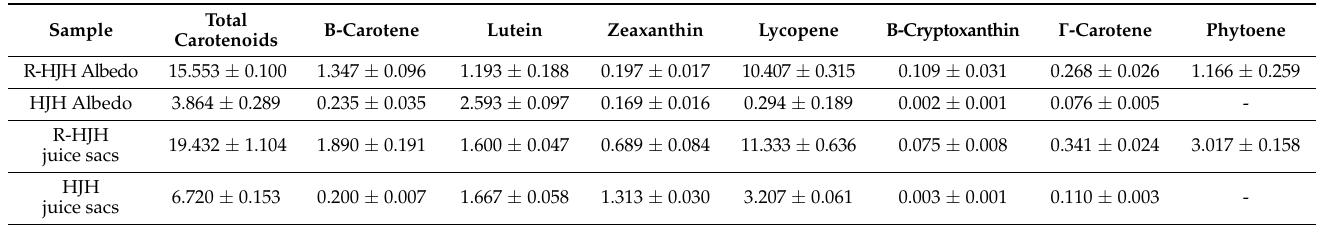
Table 1. Carotenoids ( µ g/g DW) in the albedo and the juice sacs of R-HJH and their corresponding wild type HJH.